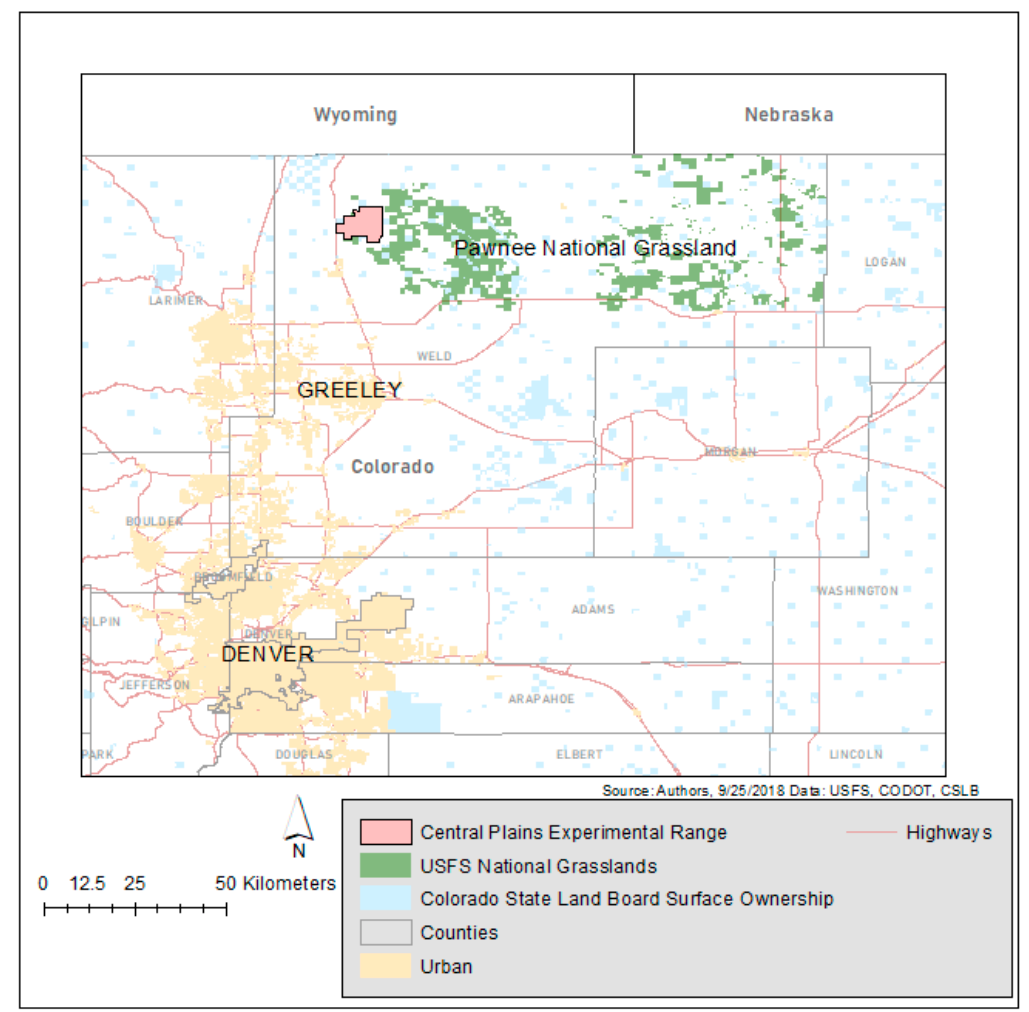
Figure 1. The Collaborative Adaptive Rangeland Management (CARM) project takes place at the Central Plains Experimental Range in Nunn, Colorado. This is a United States Department of Agriculture (USDA) Agricultural Research Service (ARS) research location. The site is located in the far Western, and therefore, the driest and warmest edge of the US Great Plains in the shortgrass steppe ecosystem, near the US Forest Service Pawnee National